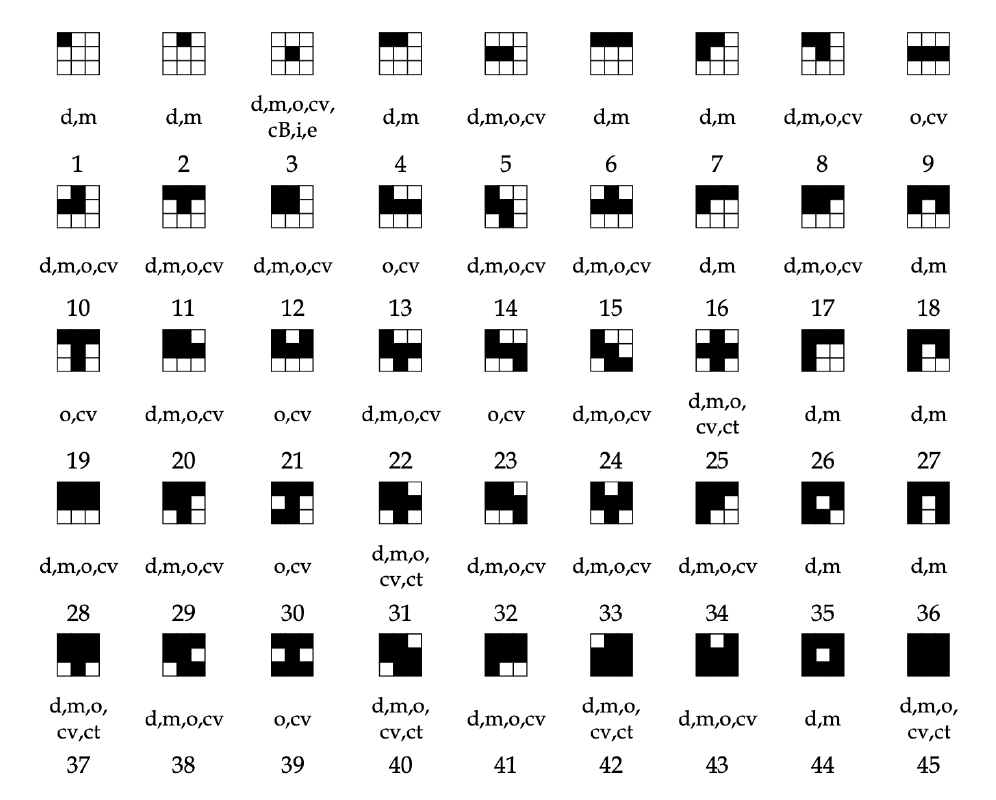
Figure 10: Rules from Guo and Du [23] applied to congruence classes, adjusted as a result of Theorem